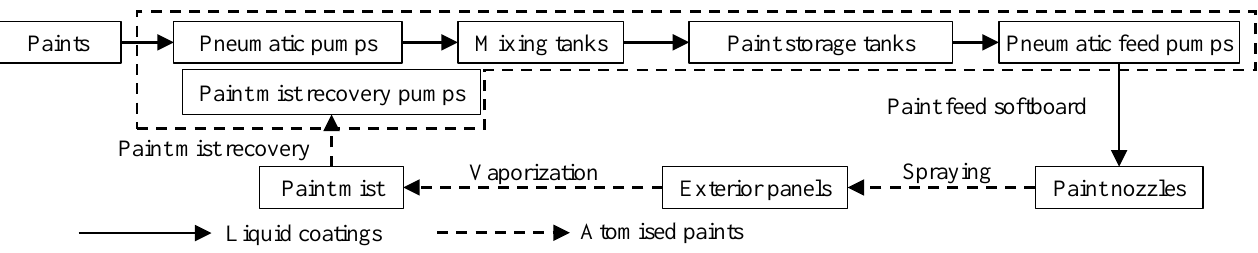
Figure 5. Particle strokes for paint spraying by spraying robots. effect are the hood perimeter, the height of the air inlet surface and the suction air